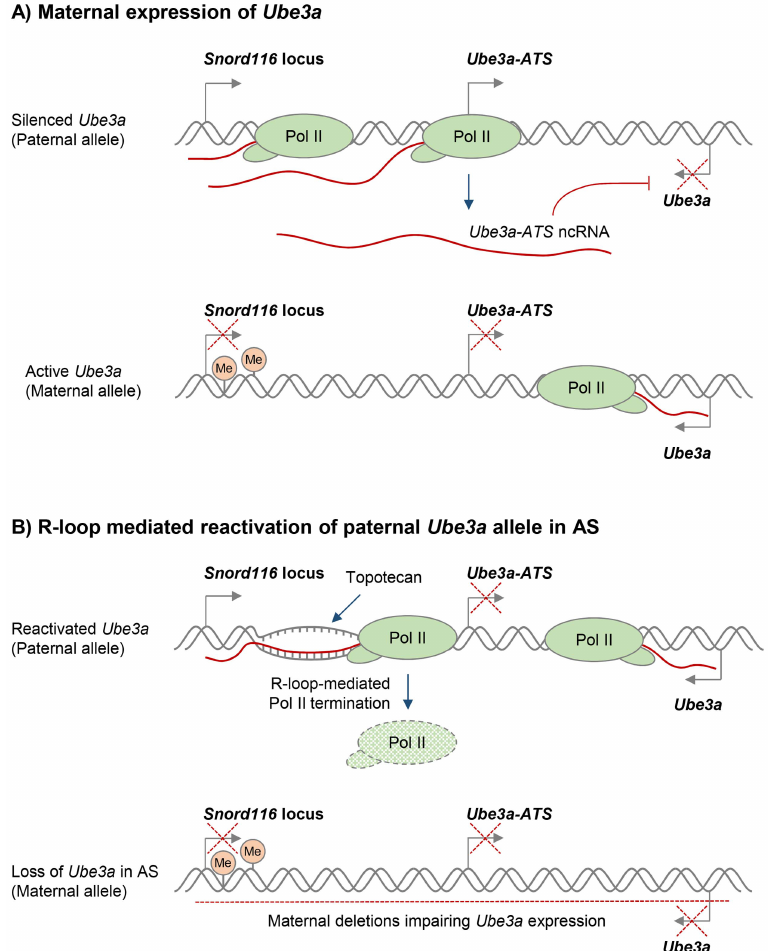
Figure 3. Potential R-loop-based therapeutic approach in Angelman Syndrome (AS). A. Neuronal expression of the paternal ncRNA Ube3a-ATS represses paternal Ube3a gene in cis [101]. DNA methylation of the Snord116 locus on the maternal allele prevents Ube3a-ATS transcription, resulting in Ube3a expression from the maternal allele. Transcriptional repression is indicated by red crosses. B. R-loop-mediated re- activation of silent paternal Ube3a gene provides a targeted therapy for AS. Deletion leading to the loss of maternal Ube3a expression detected in AS is indicated by the red dashed line. Topotecan treatment increases R-loop levels over the Snord116 locus, resulting in chromatin decondensation, inhibition of Pol II transcription through Ube3a-ATS , and increased expression of Ube3a from the paternal allele